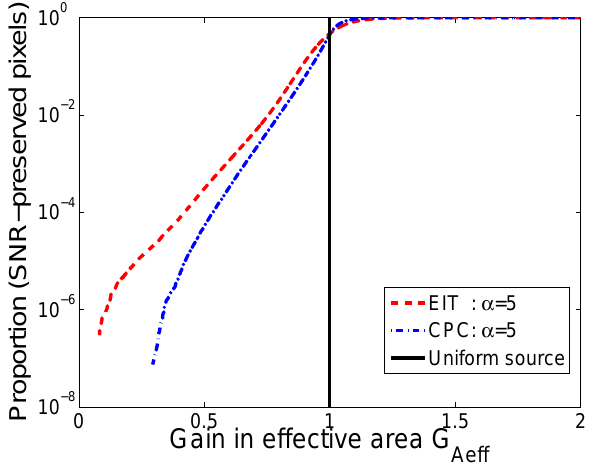
Fig. 7. Proportion of pixels having a similar SNR at low resolu- tion (far from the Sun) and at high resolution ( α = 5 times closer to the Sun) for a given change in effective area. When getting closer to the Sun, one may have a reduced effective area and still have a proportion of pixels with preserved